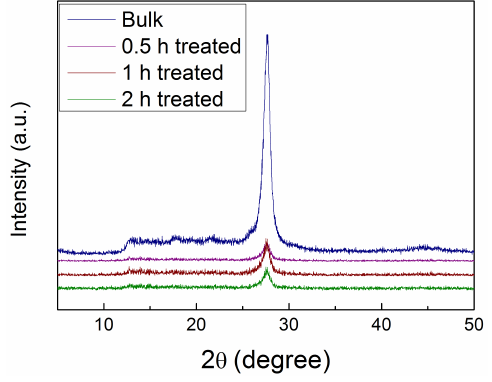
Figure 2. X-ray diffraction (XRD) patterns of bulk g-C 3 N 4 and g-C 3 N 4 nanosheets exfoliated at different acid treatment times.